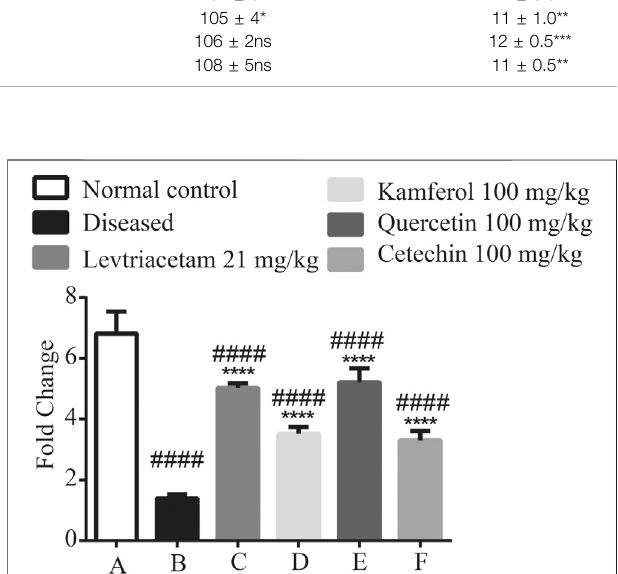
FIGURE 6 | Graphical representation of the mean ± SD relative expression levels of SV2A. The treatment of PF signi fi cantly improves the protein expression. The data were analyzed by one-way ANOVA followed by Tukey ’ s post hoc test. Comparison of Group A vs B, C, D, E, and F denoted by (#), while Group B vs C, D, E, and F is denoted by (*). * p < 0.05. ** p < 0.01, *** p < 0.0005, and **** p <